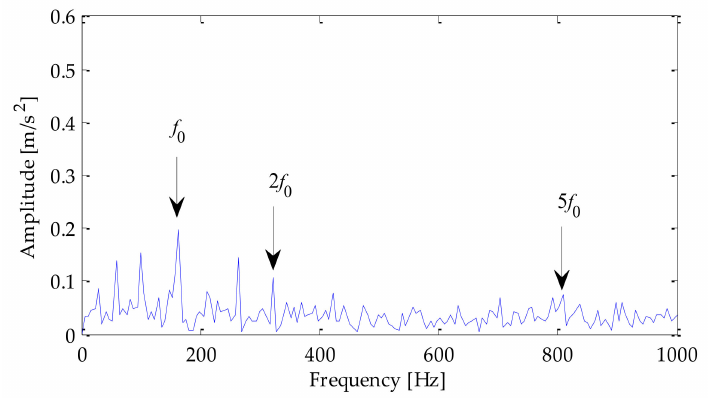
Figure 31. Analysis of signal envelope spectrum after noise reduction based on EMD–RobustICA.